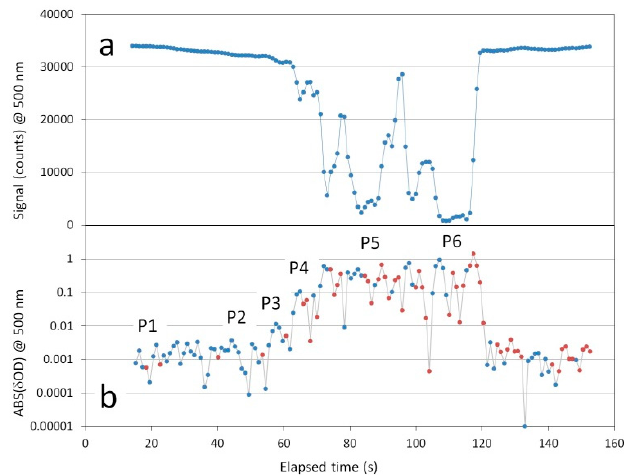
Figure 2. Evolution of the signal at 500 nm taken from SPC1 ( a ) and the absolute value of the 1-s variations of the apparent optical depth ( b ) at the same wavelength, along a period of 2.5 min. Blue dots correspond to increments in apparent optical depth (OD) (signal decreases), whereas red dots correspond to decrements in apparent OD (signal increases). X -axis is time in seconds elapsed from the start of the measurement series. A cloud patch passed through the field of view of the measurement system, producing large variations in the signal and in the apparent OD.